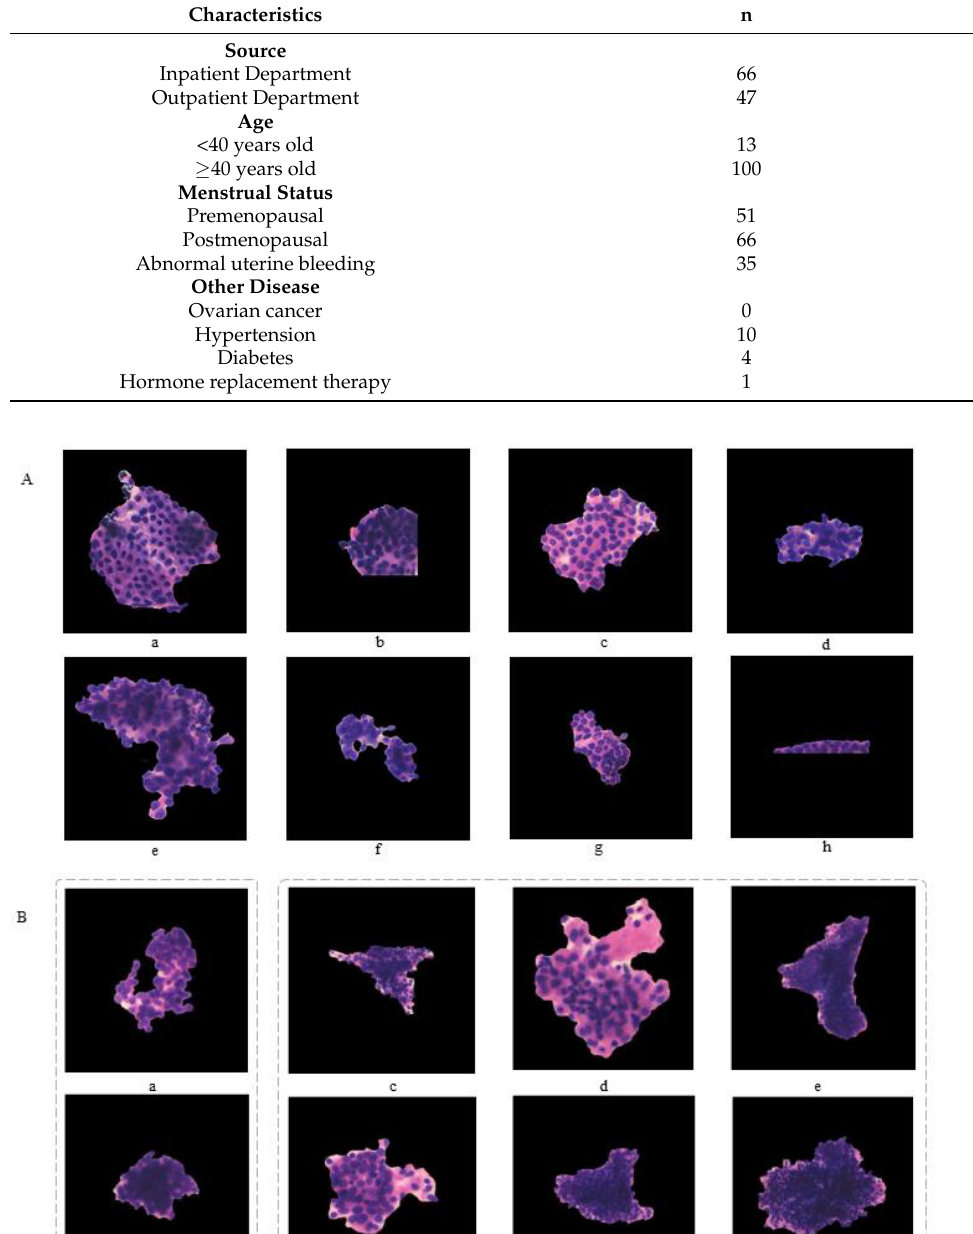
Table 1. Patients characteristics.